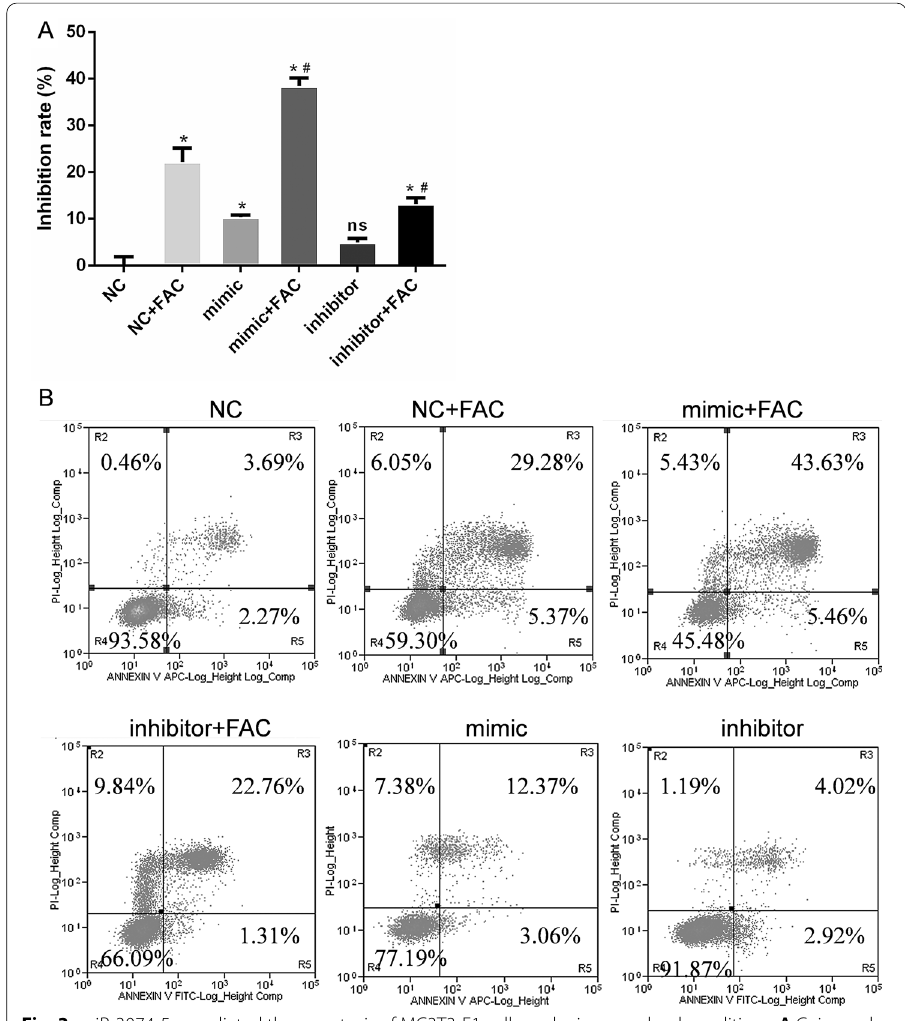
Fig. 3 miR‑3074‑5p mediated the apoptosis of MC3T3‑E1 cells under iron overload conditions. A Gain‑ and loss‑of‑function experiments were performed by transfecting cells with a miR‑3074‑5p mimic and miR‑3074‑5p inhibitor, respectively. The CCK‑8 assay was used to investigate the effect of miR‑3074‑5p on cell viability. * P < 0.05 vs. the NC. # P < 0.05 vs. the NC FAC group. ns P > 0.05 vs. the NC group. FAC concentration: + 1.8 mM. B Annexin V‑FITC/PI staining was performed to confirm the function of miR‑3074‑5p in cell apoptosis. C Quantitative analysis of late apoptosis rate based on Annexin V‑FITC/PI staining. * P < 0.05 vs. the NC. # P < 0.05 vs. the NC FAC group. ns P > 0.05 vs. the NC +